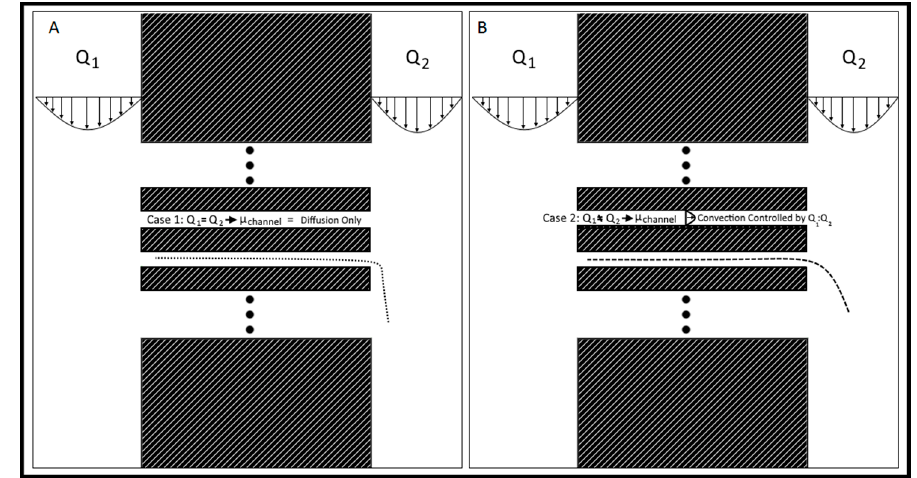
Figure 2. Flow rate controlled chemical gradient. ( A ) Q 1 = Q 2 , the system is in a state of even flow, resulting in bulk diffusion of chemicals from left to right. The speed of Q 2 determines the rate of fall-off and degree of accumulation downstream. ( B ) Q 1 > Q 2 , the system is in a state of uneven flow, resulting in convection-enhanced transport across the channel array from left to right. The rate at which the small molecules cross the channels is controlled by the ratio Q 1 :Q 2 , with larger ratios resulting in faster transport.